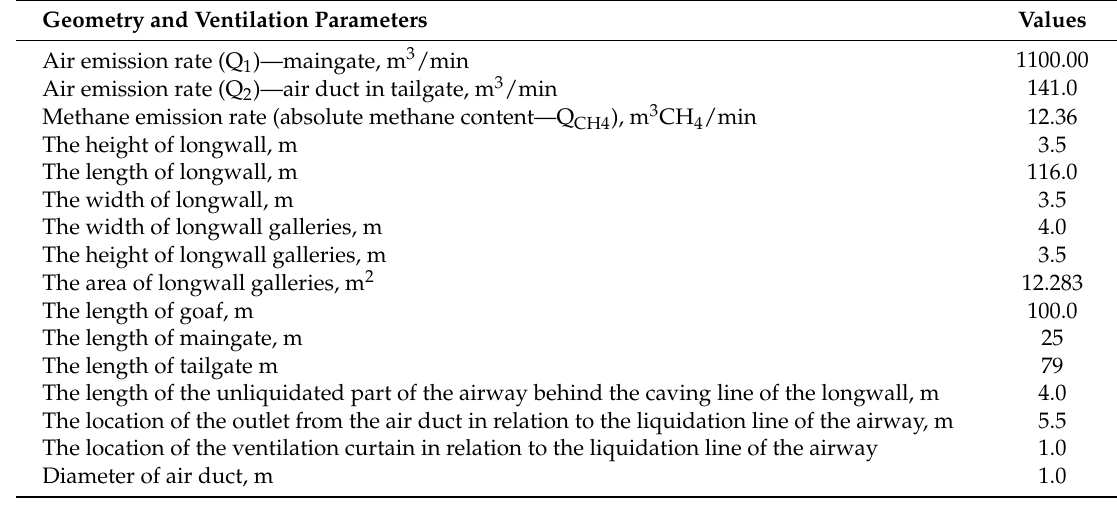
Table 2. Geometry and ventilation parameters of the test region.